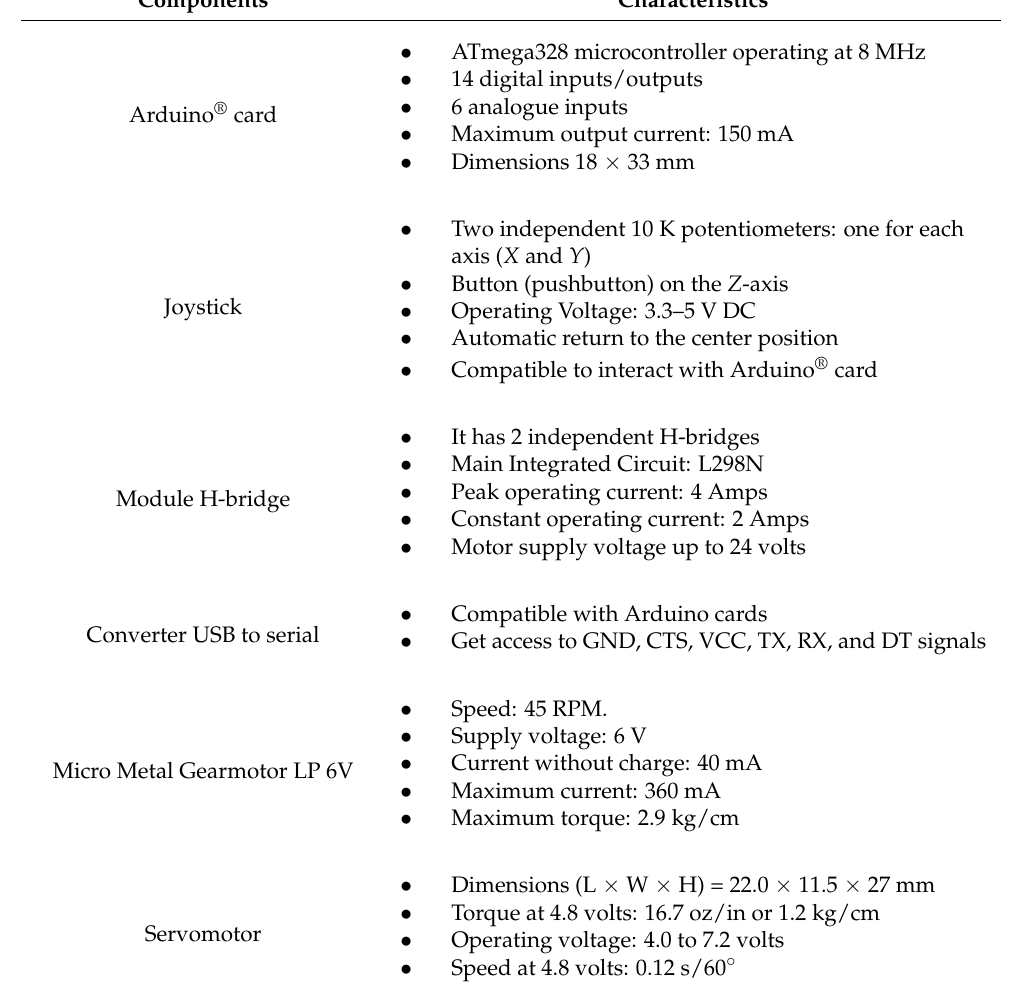
Table 2. Hardware and software